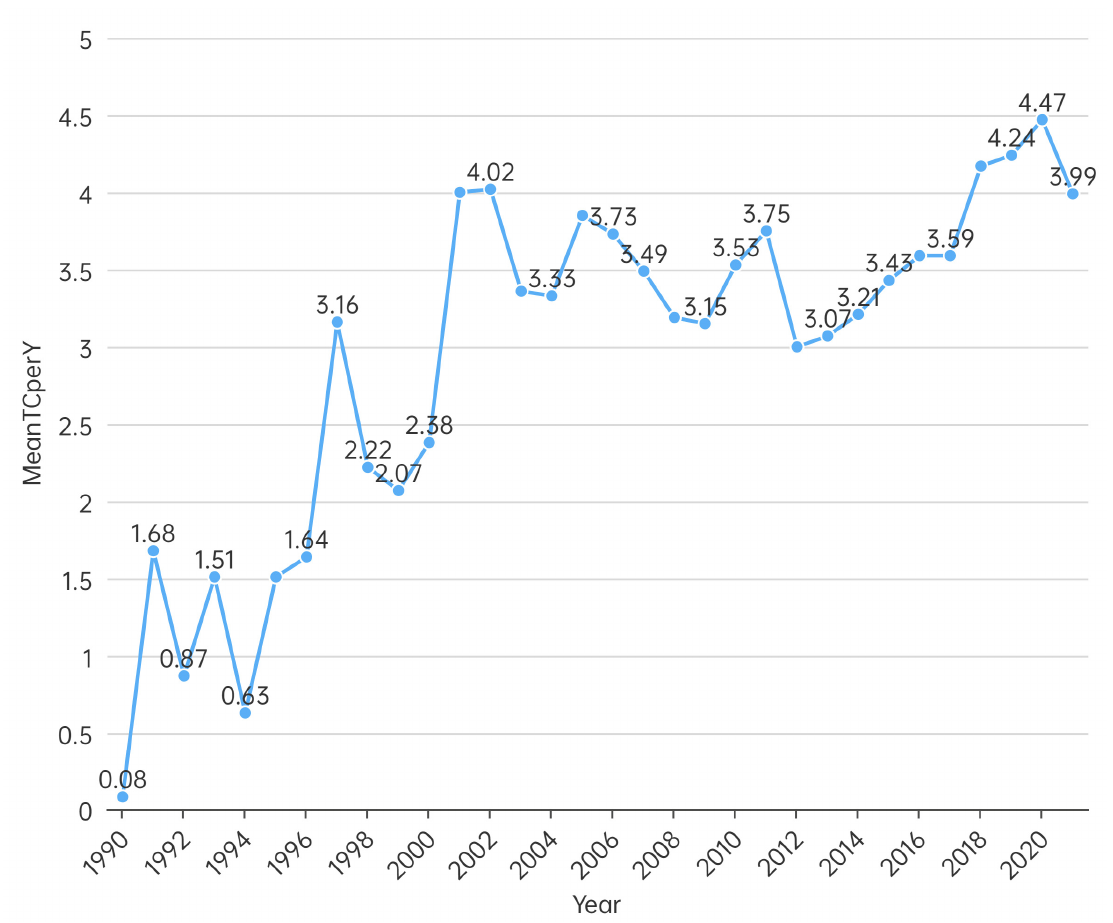
Figure 3. Average annual citations in the field of restoration ecology from 1990 to 2021.